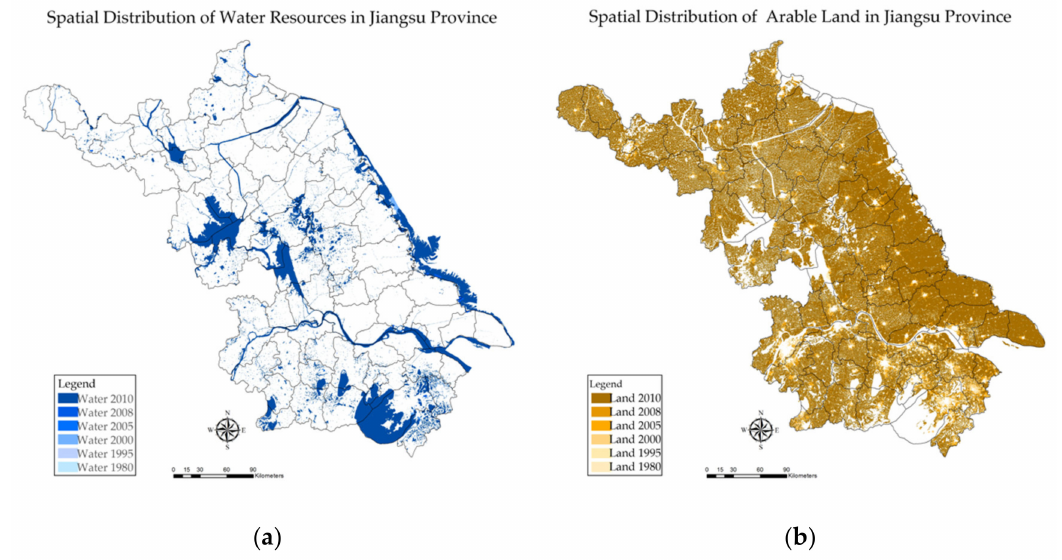
Figure 1. Water resources and arable land in Jiangsu Province: ( a ) Spatial distribution of water resources in Jiangsu Province; ( b ) Spatial distribution of arable land in Jiangsu